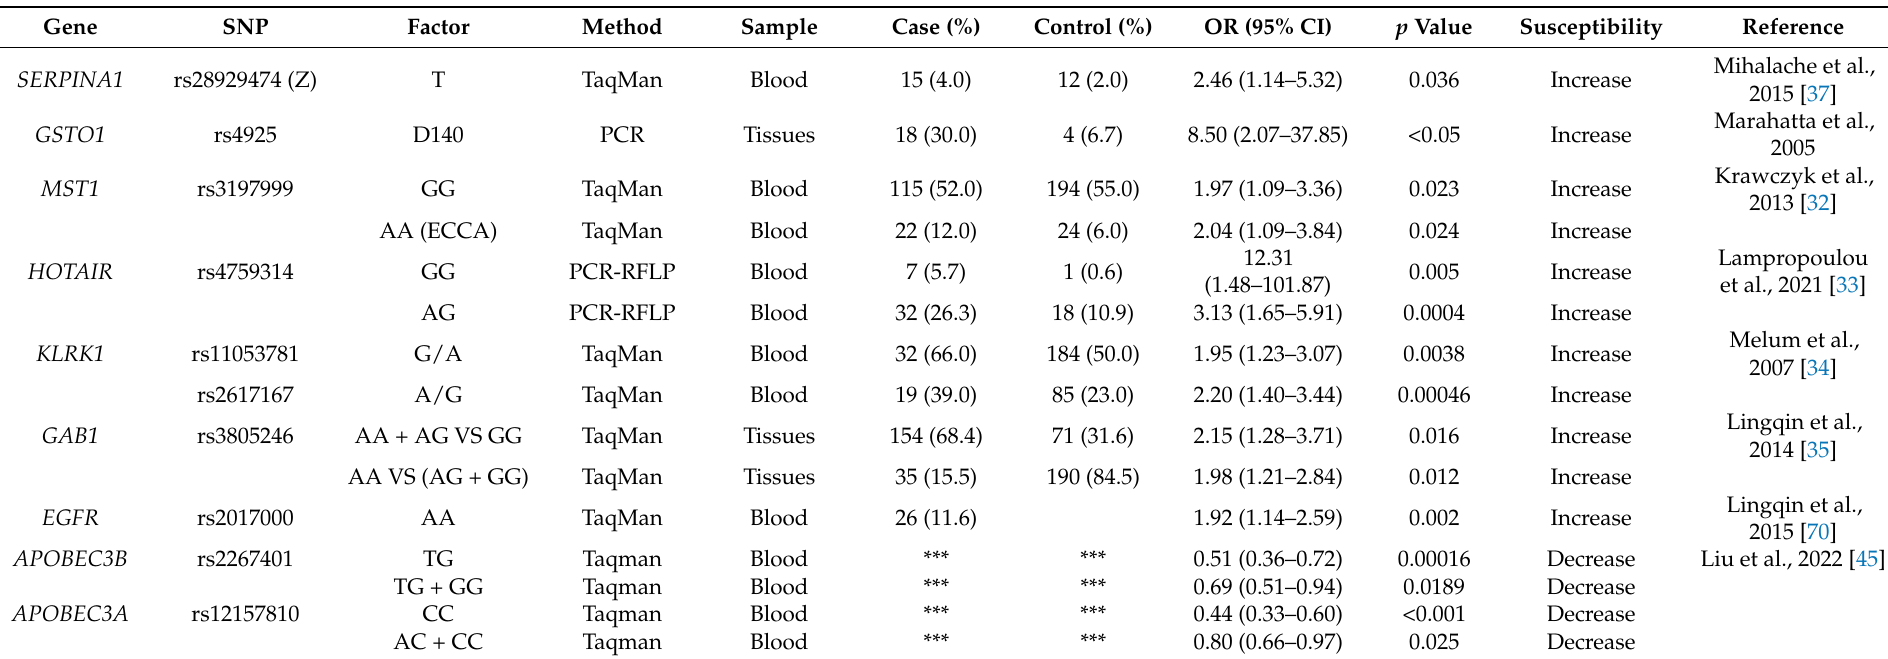
Table 4. SNPs in other genes associated with susceptibility to CCA. Various studies investigated the gene SNPs related to the susceptibility of